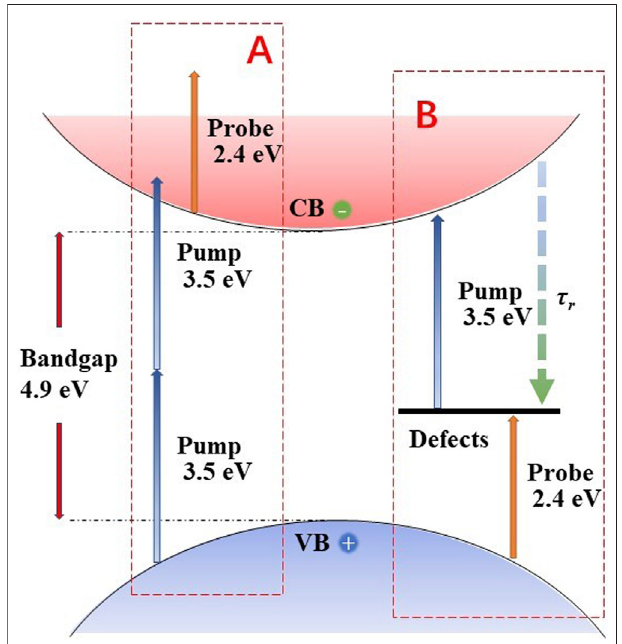
FIGURE 5 | Schematic diagram of the energy levels and carrier decay processes of β -Ga2O3: Sn. The blue up arrow represents the two-photon excitation, the green down arrow represents the recombination process related to the defect state, and the orange up arrow represents the transition from the valence band to the defect